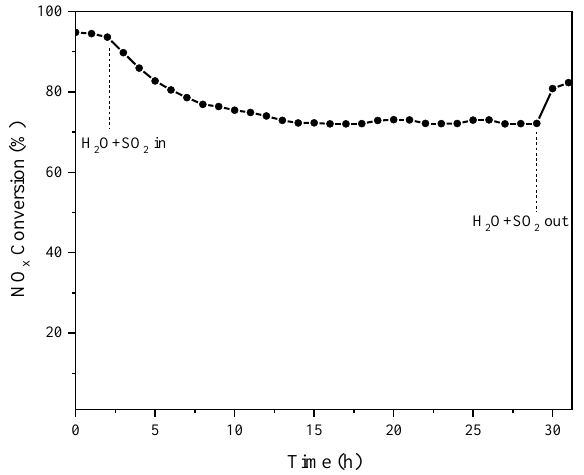
Figure 9. Stability test of the 0.5%CeO 2 / quasi-MIL-101 catalyst in the presence of SO 2 and H 2 O at 250 ◦ C. Reaction conditions: 500 ppm NO, 500 ppm NH 3 , 5% O 2 , 5% H 2 O and 100 ppm SO 2 , balance N 2 , GHSV = 79,000 h − 1 .